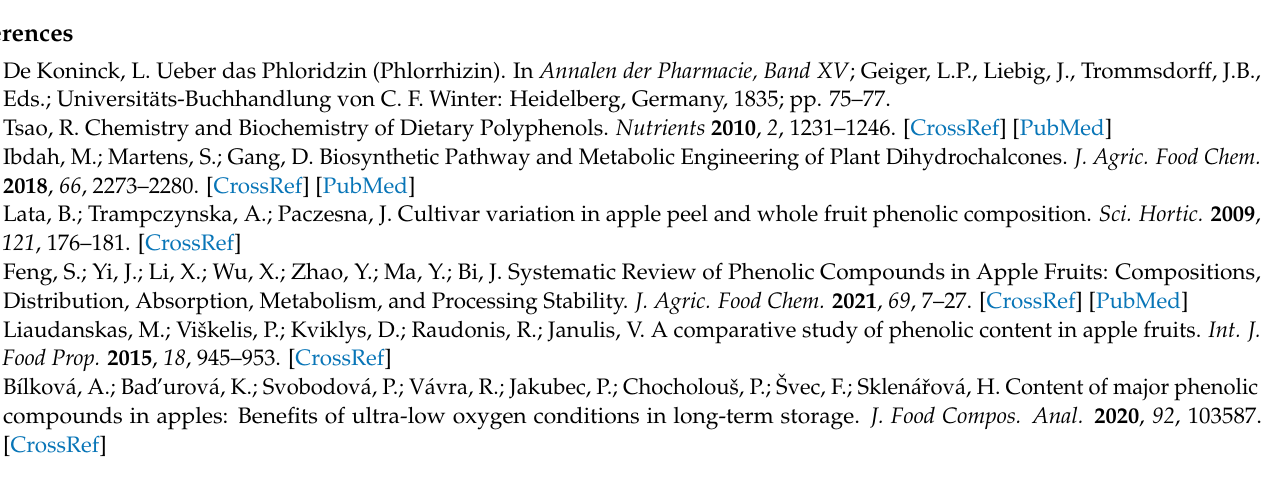
solution, Figure S9: FIAgram of apple bark extract, Figures S10–S12: The concentration of individual phenolic compounds expressed in mg/g DW obtained from apple leaves, bark, and buds. Table S1: List of published HPLC conditions of different phenolic substances in apple leaves, Table S2: The separation conditions of tested columns, Table S3: Content of phenolic compounds in leaves of 9 cultivars, Table S4: The total antioxidant activity of tested cultivars in µ